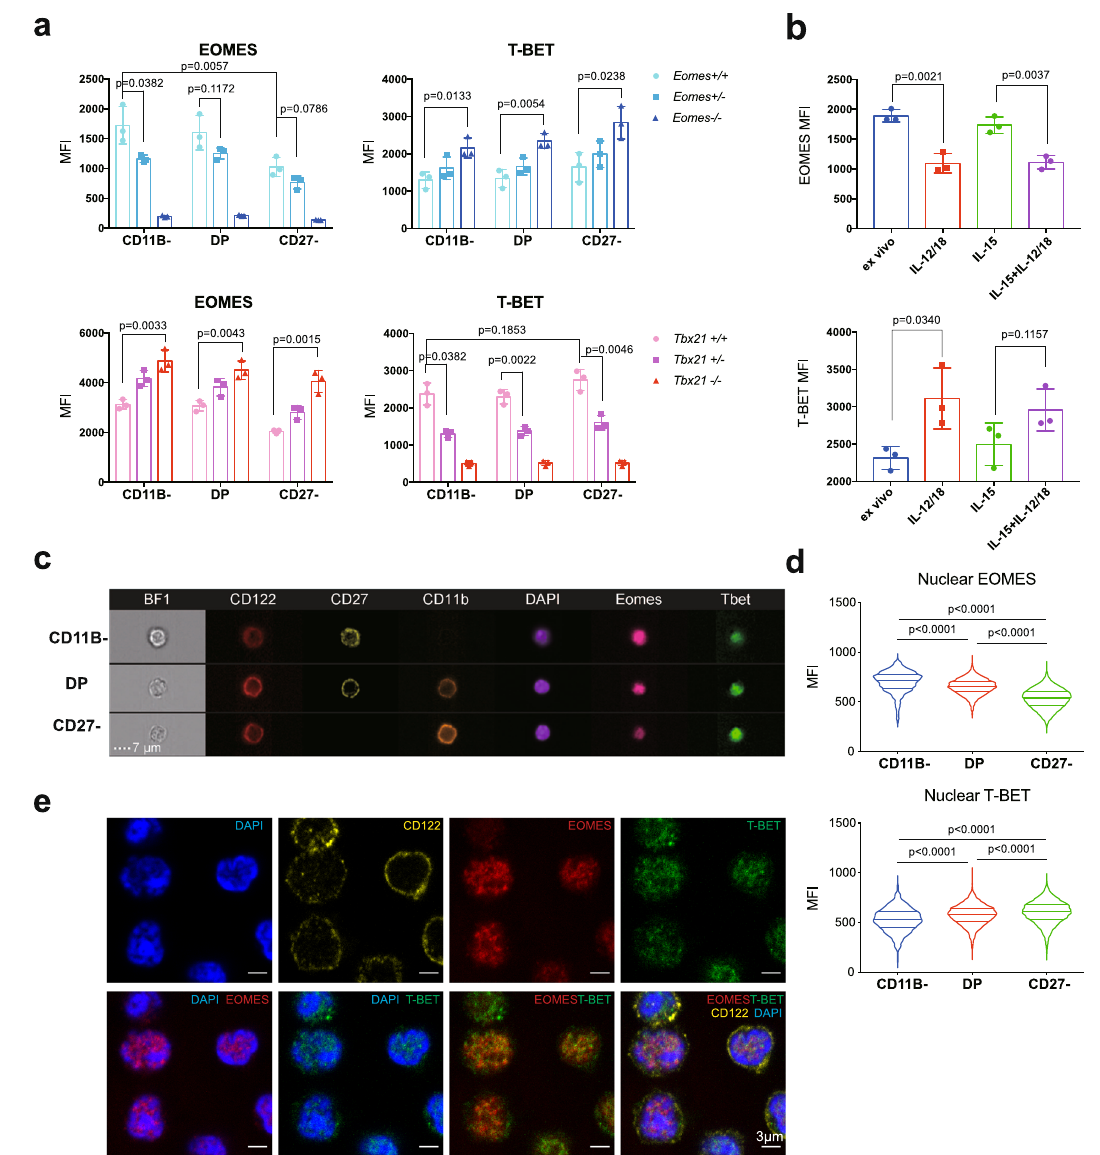
Fig. 1 EOMES and T-BET balance each other during NK cell maturation. a Flow cytometry measurement of T-BET and EOMES in gated NK cells from WT, Tbx21 + / − , Tbx21 − / − , Ncr1 Cre/ + ( Eomes + / + ), Ncr1 Cre/ + X Eomes lox/ + ( Eomes + / − ) and Ncr1 Cre/ + X Eomes lox/lox ( Eomes − / − ) mice, as indicated. Bar graphs show the mean ± SD fl uorescence intensity (MFI) of EOMES and T-BET staining in gated NK cell subsets from spleen. Data are representative of 3 experiments and 3 mice are shown for each group. b WT spleen cells were stimulated O/N in the indicated conditions and T-BET and EOMES expression were measured by fl ow cytometry. Bar graphs show the mean ± SD fl uorescence intensity (MFI) of EOMES and T-BET staining in gated NK cells. Data are representative of 2 experiments and 3 mice are shown for each group. c Image stream X (ISX) analysis of T-BET and EOMES expression in gated NK cells. Representative images are shown for the three NK cell subsets. CD122 staining was used to visualize the membrane. d Quanti fi cation of nuclear T-BET and EOMES in gated NK cell subsets analyzed with IDEAS software. Bar graphs show nuclear MFI of T-BET and EOMES for the indicated subsets, normalized to the level of each TF in immature CD11B- NK cells. N = 1232, 5157 and 22403 cells analyzed for CD11B-, DP and CD27- subsets, respectively. e NK cells were sorted from WT mice in immature or mature subsets and subsequently stained for nucleus (DAPI), T-BET, EOMES and CD122 for confocal microscopy analysis. Shown are representative images of each staining and combinations for immature NK cells. Images are representative from three individual experiments. Unpaired t tests (two-tailed) were used for statistical analysis of data presented in this fi